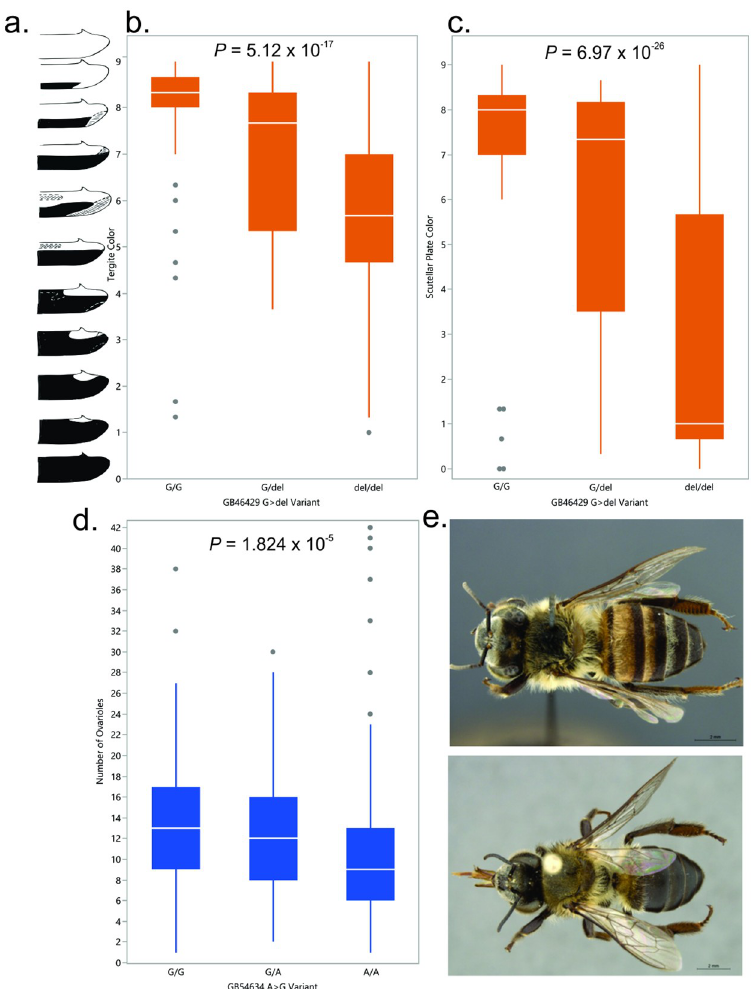
Fig 3. Allele distribution for variants discovered in GB54634 and GB46429 (Ebony) , as well as respective color phenotypes. a. Ruttner [2] ranking for tergite color, also applied to scutellar plate phenotyping [19]; b. Allelic distribution of the NC_007070.3:g.14101325G > del;p.R69Efs � 85 variant for tergite color and c. scutellar plate color; d. Allelic distribution of the NC_007076.3:g.4492792A > G;p.Tyr128 � variant for ovariole number; and e. Individuals from the Apis mellifera scutellata (above) and A . m . capensis (below) representing the variation in color [29].